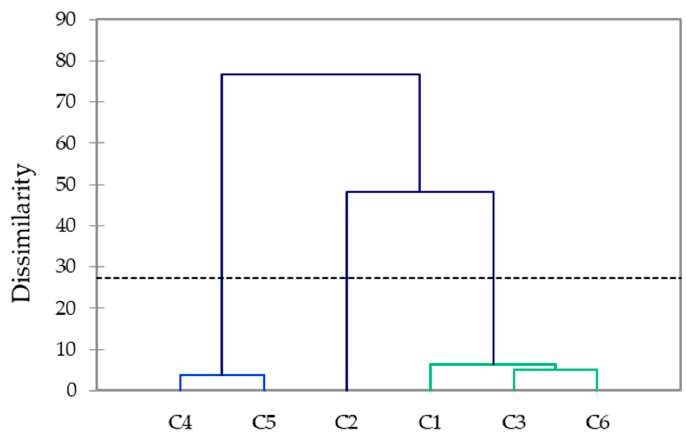
Figure 5. Agglomerative hierarchical clustering of the studied coffee beans based on their macro-, microelement, N, C, H, and polyphenol contents. The dotted line represents automatic truncation, resulting in three groups: group 1 (light blue), group 2 (blue), and group 3 (green).